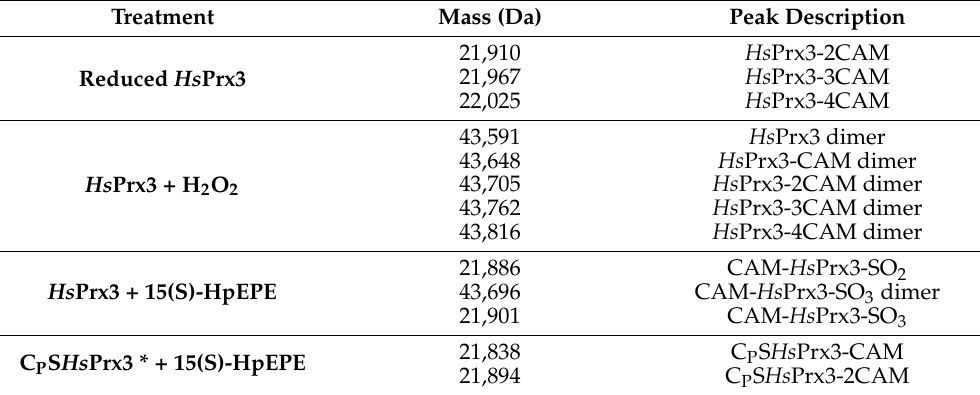
Figure 5. MS analysis of the modifications of Hs Prx3 caused by 15(S)-HpEPE. Mass spectrum of ( A ) reduced Hs Prx3 (10 µM); ( B ) reduced Hs Prx3 treated with H 2 O 2 (20 µM); ( C ) reduced Hs Prx3 treated with 15(S)-HpEPE (10 µM, black trace; and 20 µM, red trace); and ( D ) reduced C P S Hs Prx3 treated with 15(S)-HpEPE (20 µM). All samples were alkylated with excess 2-iodoacetamide after treatment (5 mM). Table 2. Mass spectrometry analysis of Hs Prx3 modifications caused by H 2 O 2 and 15(S)-HpEPE.